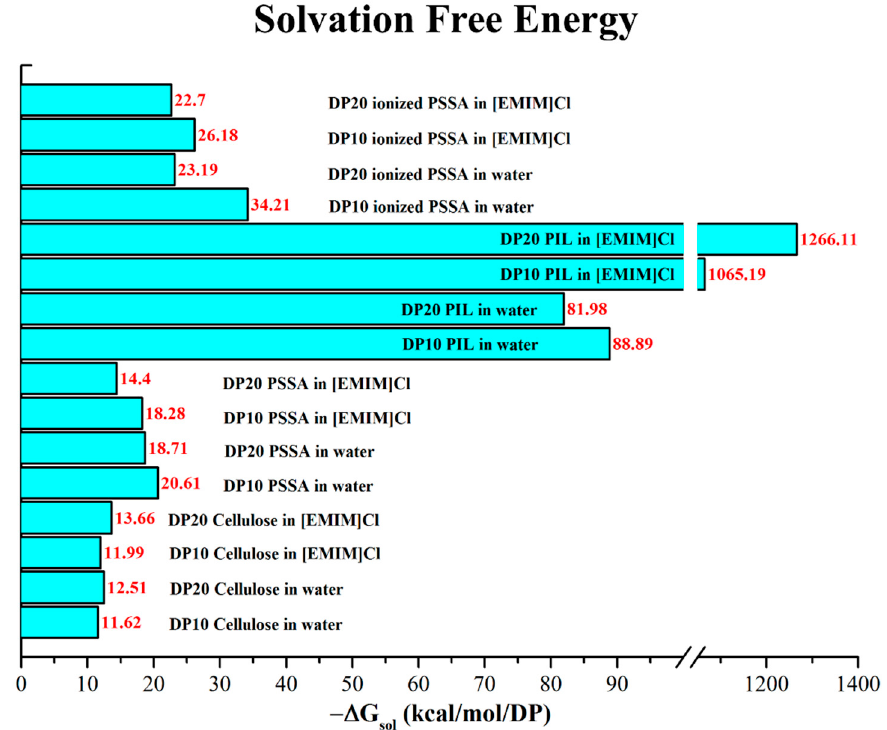
Figure 4. Solvation free energies (per DP) of polymeric catalysts and cellulose chains in [EMIM]Cl and aqueous solutions.